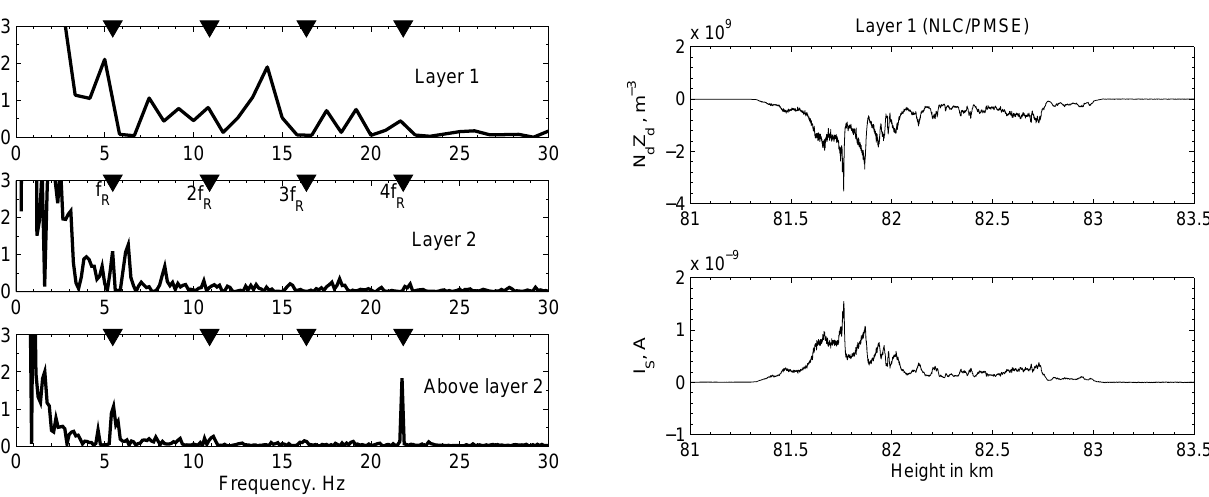
Fig. 6. Fourier frequency analysis of layer 1, 2 and the region above the layers. We show the payload spin frequency f r and its harmon- ics up to 4 f R .